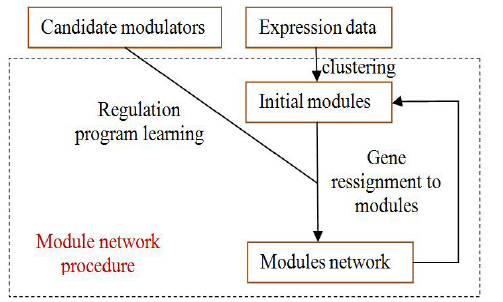
Figure 4. The process of module-network learning. It is an iterative procedure that determines both the partition of genes to modules and the regulation program for each